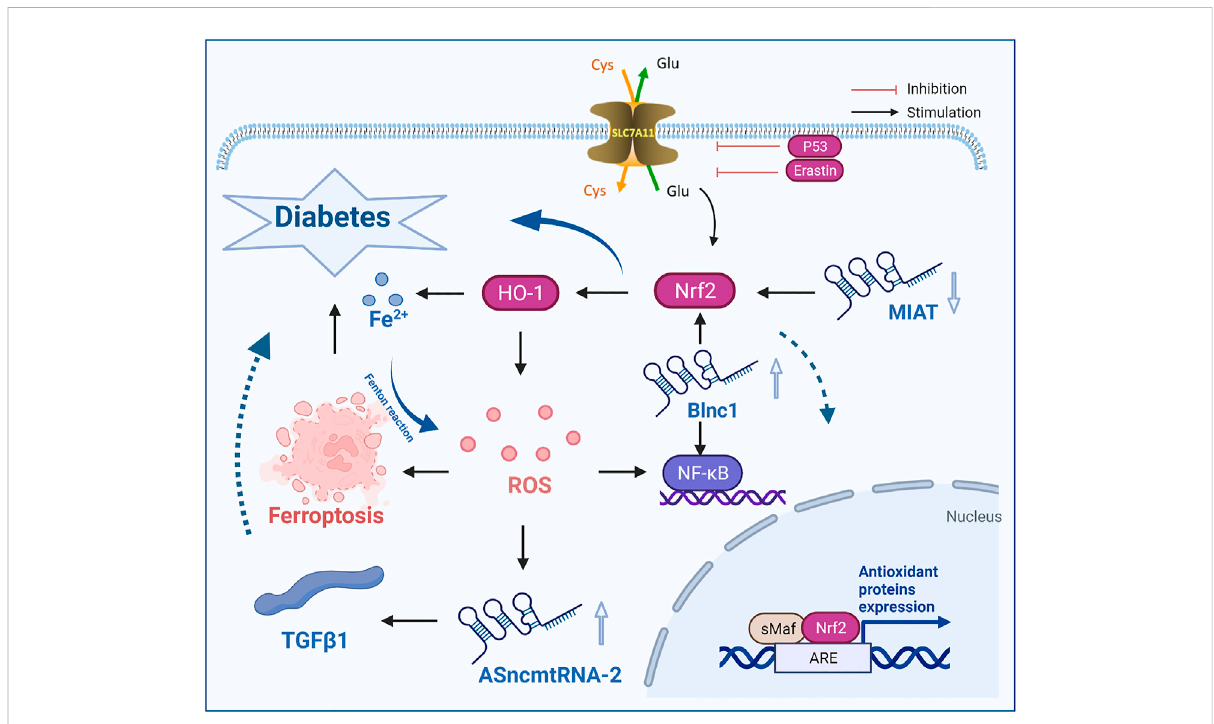
FIGURE 2 LncRNAs in fl uence the occurrence and development of diabetes by regulating the ferroptosis-inducing factor ROS and the key factor Nrf2. ROS, reactive oxygen species; TGF β 1, transforming growth factor- β 1; lncRNA MIRT, myocardial infarction related transcripts; Cys, cystine; Glu,